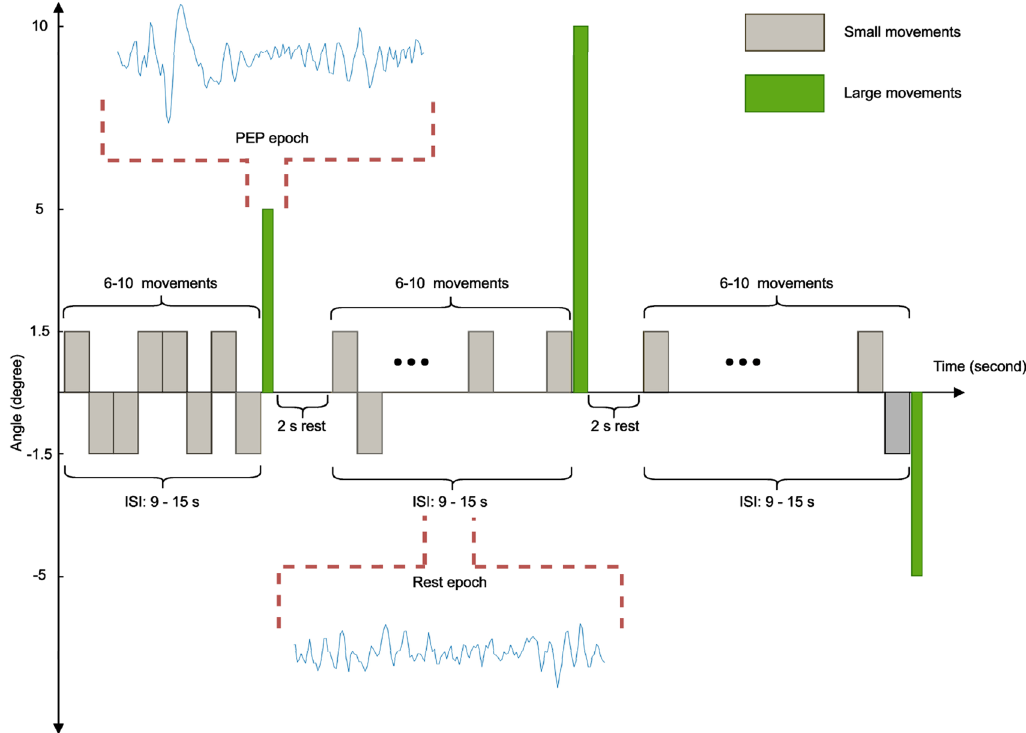
Figure 2. The time sequence of the experiment. The gray bars indicate small movements (1.5 degrees), and green bars—perturbations (5 and 10 degrees), respectively. The interstimulus interval between two consecutive perturbations (large movements) was randomized to [9, 15] s by imposing 6 to 10 small movements. There was a 2-s rest time after the perturbation during that time, the position of the glider did not change, and it stayed at the same position. Additionally, we used the interval between perturbations as rest epochs where small movements were KRC1 robot (Kuka AG, Augsburg, Germany) was programmed to move the glider in two different directions (left and right) with three tilting angles of 1.5°, 5°, and 10°. We designed an oddball paradigm 48,49 to make the perturbations unpredictable for participants in a way that the participants experienced two kinds of movements consisting of small (standard stimuli) and large movements (target stimuli). Small movements took place at low speed and more often than large movements, while participants rarely underwent large movements (perturba- tions) at high speed during the experiment. For this purpose, 6 to 10 small movements were considered between consecutive perturbations, which resulted in an interstimulus interval (ISI) of 9–15 s. Standard stimuli occurred in both directions with an angle of 1.5°, and perturbations occurred in both directions with tilting angles of 5° and 10°. These rare perturbations were perceived as a threatening event for participants, and they resulted in the appearance of perturbation-evoked potential. The time scheme of the paradigm is demonstrated in Fig. 2, illustrating the timing of small and large movements. The robot continuously tilted the glider in the left and right directions during the small movements until a perturbation occurred. Then, the glider stayed at a tilted position for 2 s and returned to the balance position at low speed. The participants performed 6 blocks in the experiment in which each block included 40 perturbations (large movements) of two different angles (5° and 10°) and directions (left and right). Forty trials consisted of 10 repetitions of each direction and angle. All trials were exposed in a random order, and a maximum of 2 succes- sive perturbations occurred for an identical angle and direction. A video of the experiment can be found in the Supplementary Material. EEG data collection. EEG signals were recorded at a sampling rate of 512 Hz using an EEGO amplifier (ANT-neuro, Enschede, Netherlands). Sixty-three active shielded Ag/AgCl electrodes were used with reference and ground electrodes located at CPz and AFz, respectively. The electrode positions were according to the Inter- national 10–5 system and were located over frontal, central, parietal and occipital areas. The electrode layout is displayed in Fig. 1 of Supplementary Material. EEG data analyses were performed using MATLAB 2019b (The MathWorks), and we utilized the EEGLAB toolbox 50 and Berlin Brain-Computer Interface (BBCI) toolbox 51 for electrophysiological analysis. A Myo armband (Thalmic Labs Inc, Kitchener, Canada) was used to detect the movement onset by measur- ing the acceleration simultaneously with EEG data. The armband was mounted on the subject’s right arm, and acceleration data were sampled at 50 Hz. EEG signals and accelerator data were synchronized using the lab streaming layer (LSL) protocol 52 .